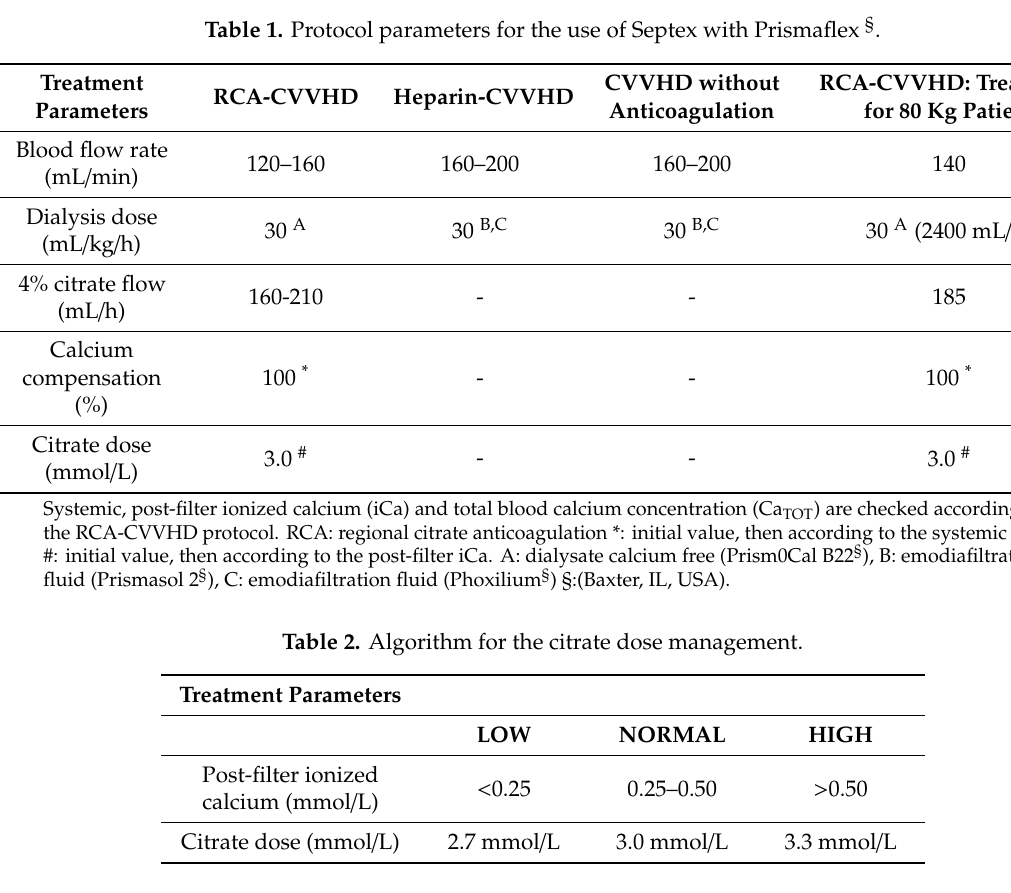
Table 3. Algorithm for the calcium compensation